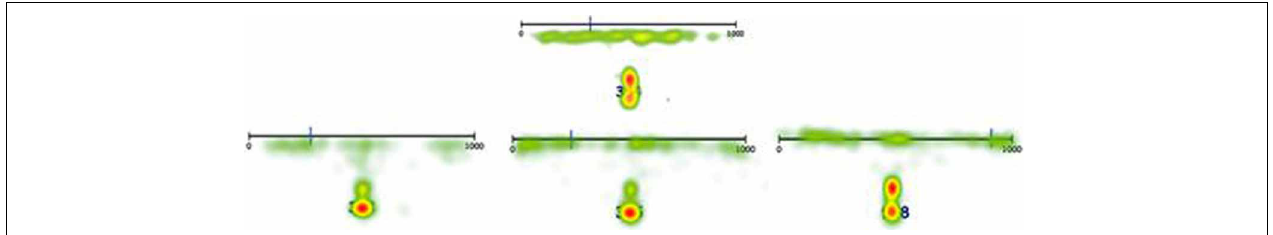
FIGURE 5 | Heat maps displaying a summary of all eye fixations of L (top) and three randomly chosen control children (bottom) in the 0–1000 symbolic number line task.